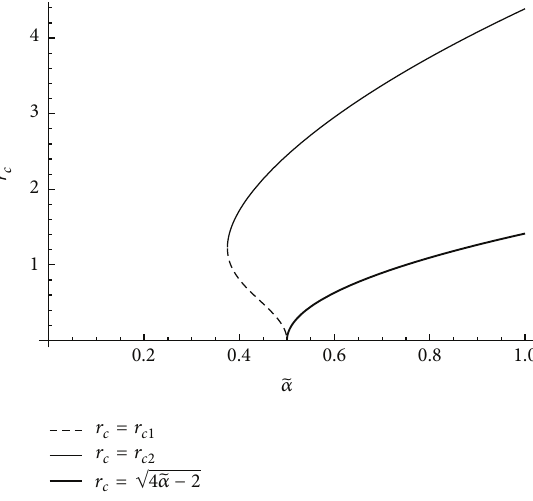
Figure 4: 𝑟 𝑐 versus ̃𝛼 for 𝑘 = −1 , 𝑄 = 1